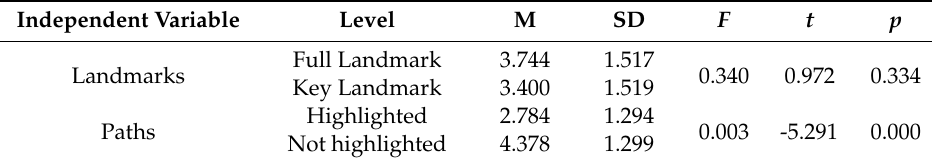
Table 2. Independent Sample t Test of cognitive load.